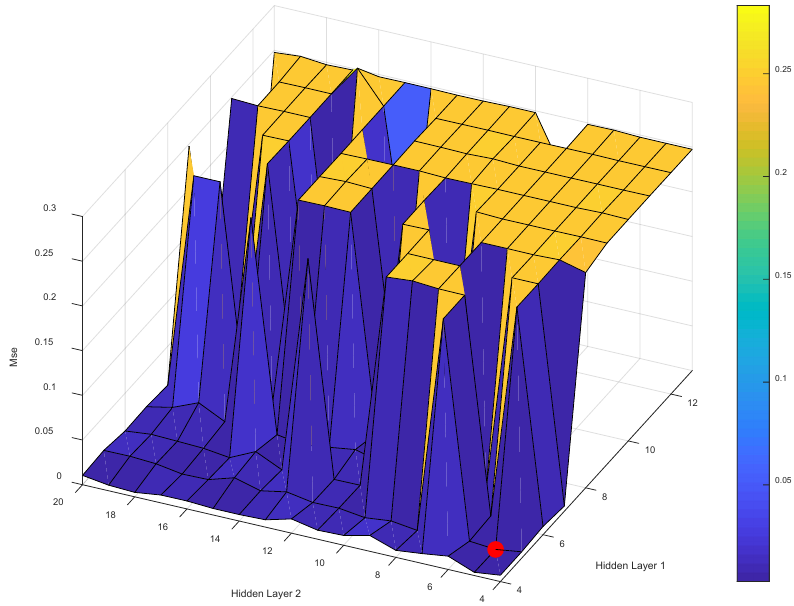
Figure 6. The effect of the hidden layer nodes on the training error of BR-ANN. Figure 7 depicts the final effect of the BR-ANN model fitting. From Figure 7, it can be seen that the training set, the test set and the overall model R are equal to 0.99445, 0.96079 and 0.98888, respectively. Table 7 shows the evaluation indexes of the actual values ob- tained after the inverse normalization operation of the final BR-ANN model.